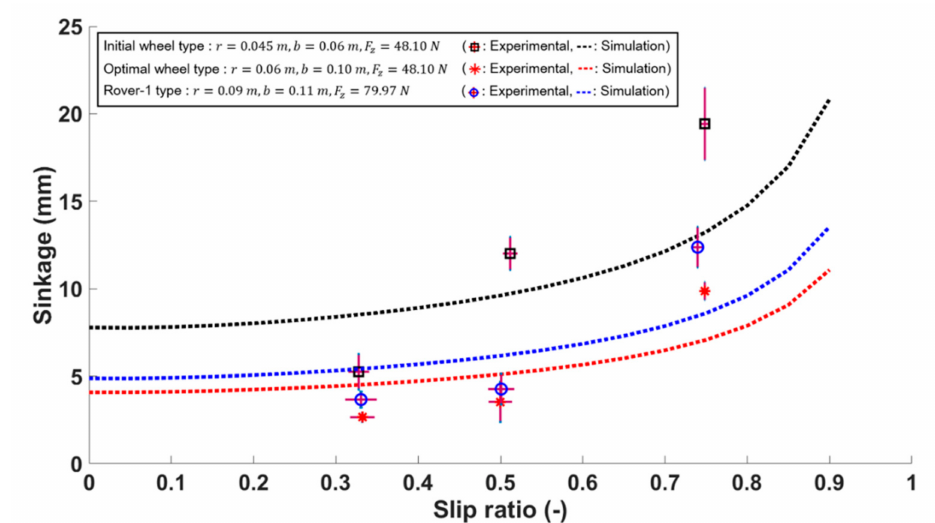
Figure 19. Comparison of experimental and simulated results for sinkage according to slip ratio and di ff erent axle load, for initial wheel type, optimal wheel type, and rover-1 type.